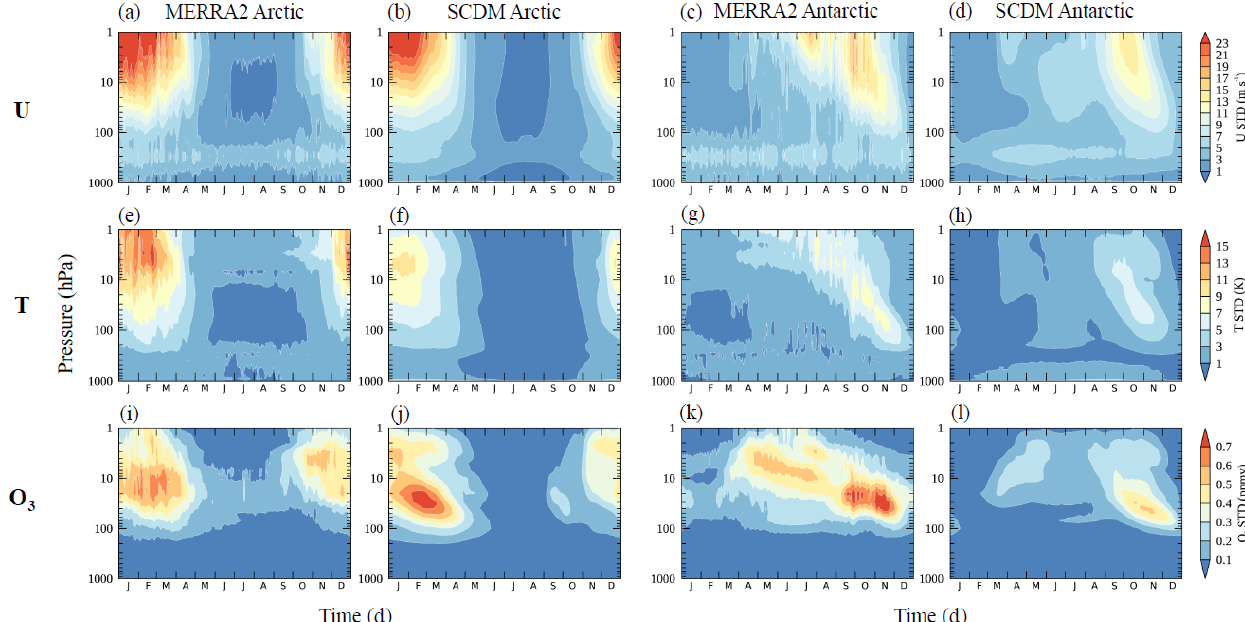
Figure 9. Interannual variability of zonal-mean (a–d) zonal wind, (e–h) temperature, and (i–l) ozone. The interannual variability is estimated by standard deviation of T and O 3 over the Arctic (60–90 ◦ N) and the Antarctic (60–90 ◦ S) and by standard deviation of U at 60 ◦ N and 60 ◦ S. Results are shown for (a, c, e, g, i, k) MERRA2 and (b, d, f, h, j, l)